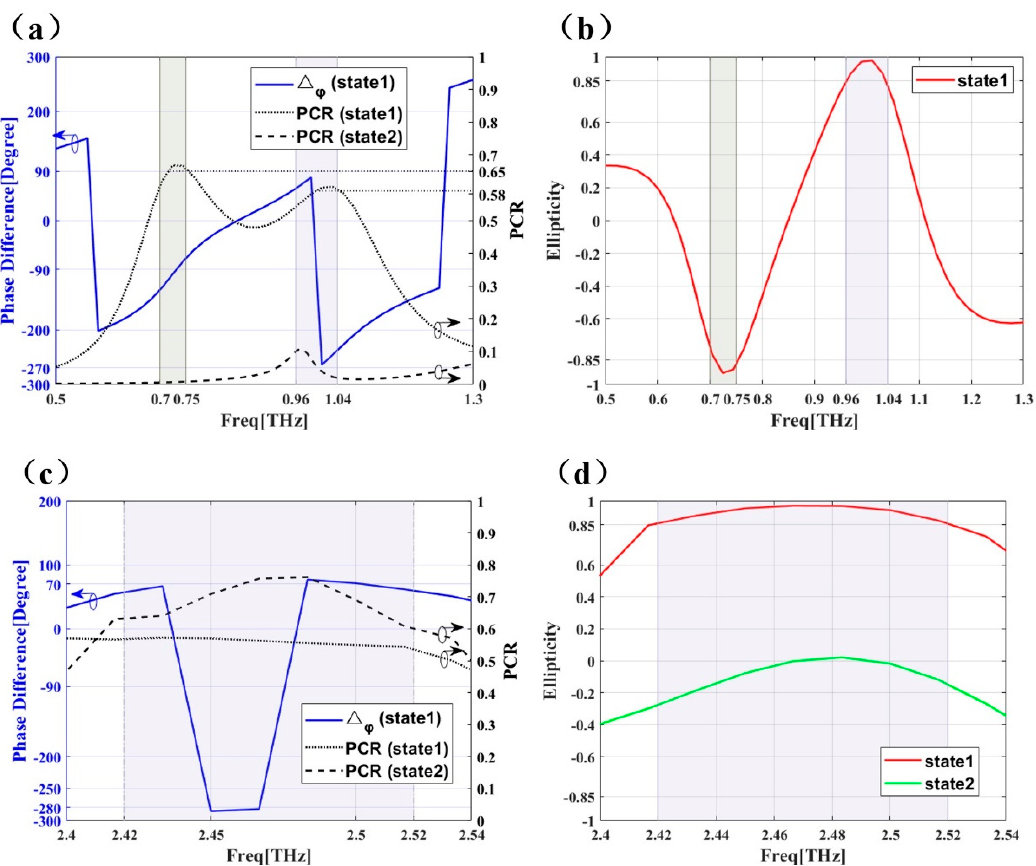
Figure 7. ∆ φ xy and PCR of antenna-PCM composite structure in 1 THz ( a ) and 2.5 THz ( c ), Normalized ellipticity of antenna-PCM combination structure in 1 THz ( b ) and 2.5 THz ( d ) at state 1 (0.0 eV) and state 2 (0.5 eV).